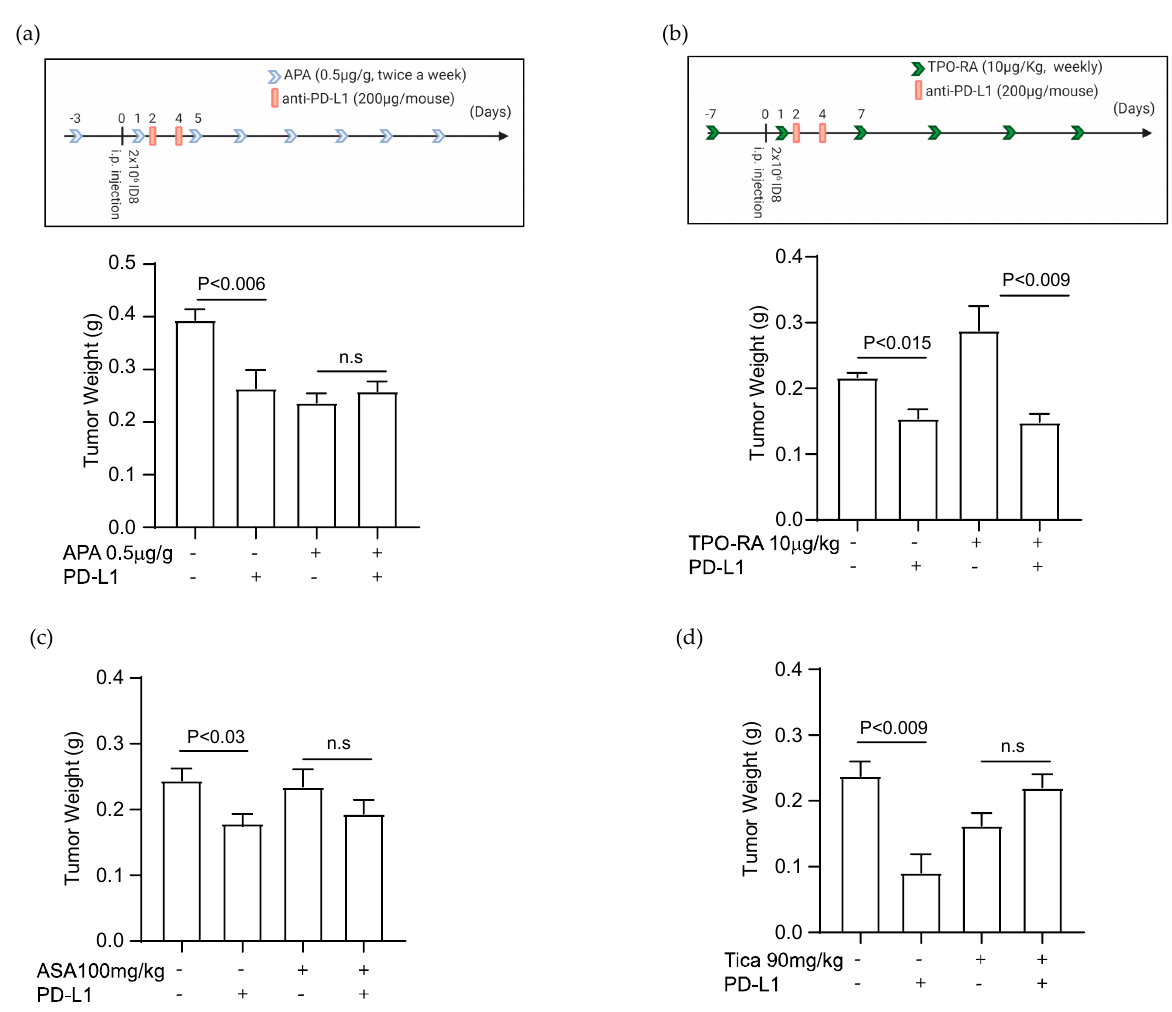
Figure 5. Platelet counts alter the response to immunotherapy with anti-PD-L1 antibody. The effect of antiplatelet antibody (APA), TPO-RA, Aspirin (ASA), or Ticagrelor (Tica) on the antitumor activity of anti-PD-L1 blocking antibody was examined in a syngeneic murine model of ovarian cancer. Tumors were induced by i.p. injection of ID8 cells to C57BL/6 mice. ( a ) The schematic presentation of the experimental protocol combining APA and anti-PD-L1 antibodies. The effect of combining APA and anti-PD-L1 antibody on the final total weight of tumor nodules resected from tumor-bearing mice ( n = 10 mice/group, two-tailed t -test). ( b ) The schematic presentation of the experimental protocol combining TPO-RA and anti-PD-L1 antibody. The effect of combining TPO-RA and anti-PD-L1 antibody on the final total weight of tumor nodules resected from tumor-bearing mice ( n = 10 mice/group, two-tailed t -test). ( c ) The effect of combining ASA (100 mg/kg daily gavage) and anti-PD-L1 antibody on the final total weight of tumor nodules resected from tumor-bearing mice ( n = 10 mice/group, two-tailed t -test). ( d ) The effect of combining Tica (90 mg/kg daily gavage) and anti-PD-L1 antibody on the final total weight of tumor nodules resected from tumor-bearing mice ( n = 10 mice/group, two-tailed t -test).